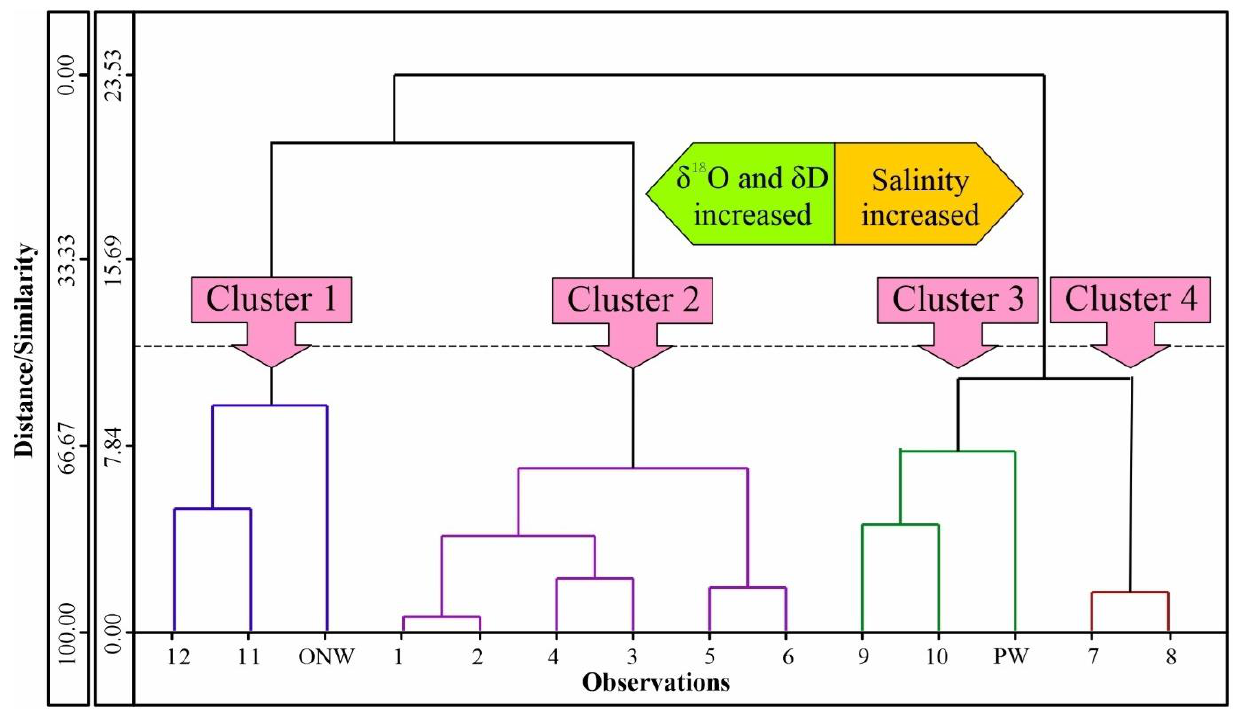
Figure 11. The four identified basic clusters’ primary physical, hydrochemical, and isotopic features for the water samples under investigation. Table 2. An overview table showing the TDS, hydrochemical, isotopic, and geographic locations of the several clusters identified in the confined or semiconfined Quaternary aquifer groundwater in the study region.